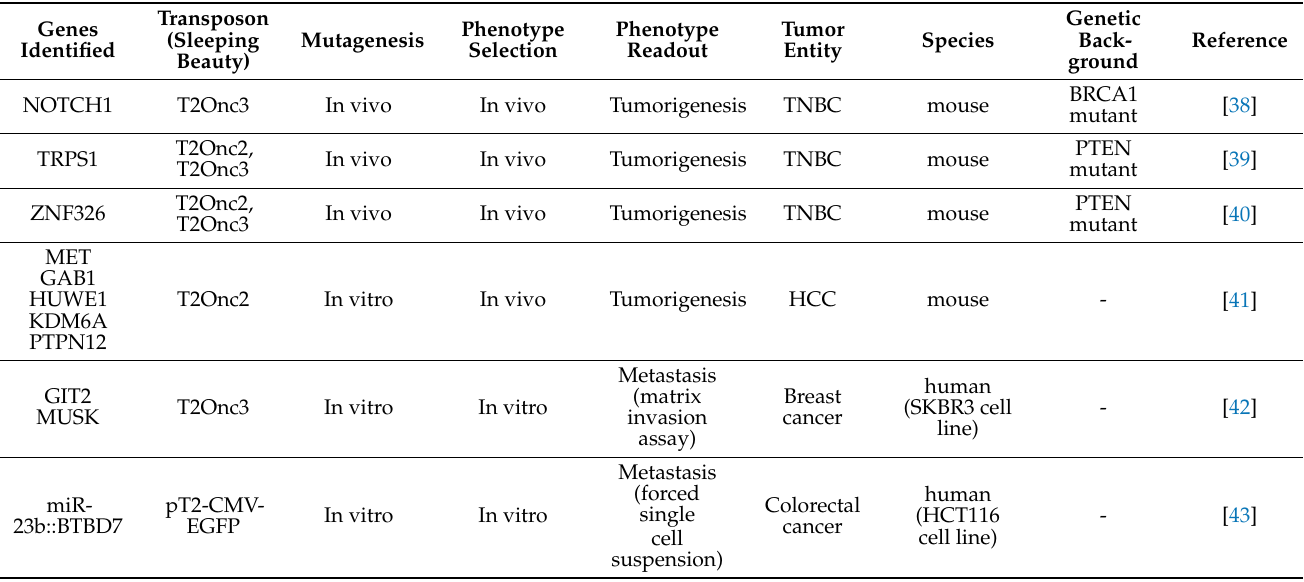
Table 1. Genome-wide transposon-based forward genetic screens identifying the roles of EMT and EMT genes.